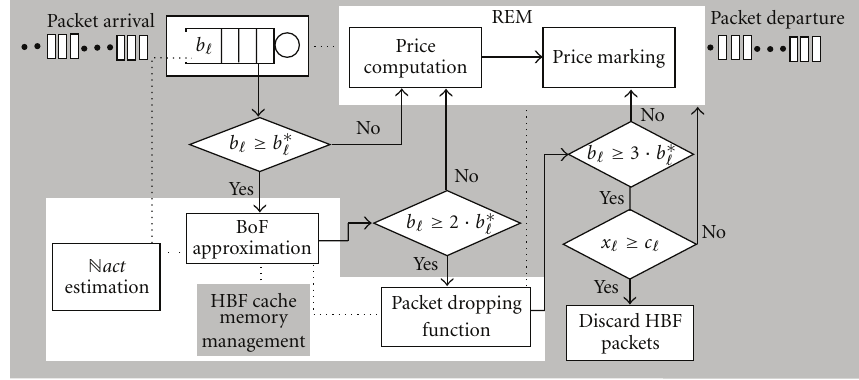
Figure 1: Block diagram of